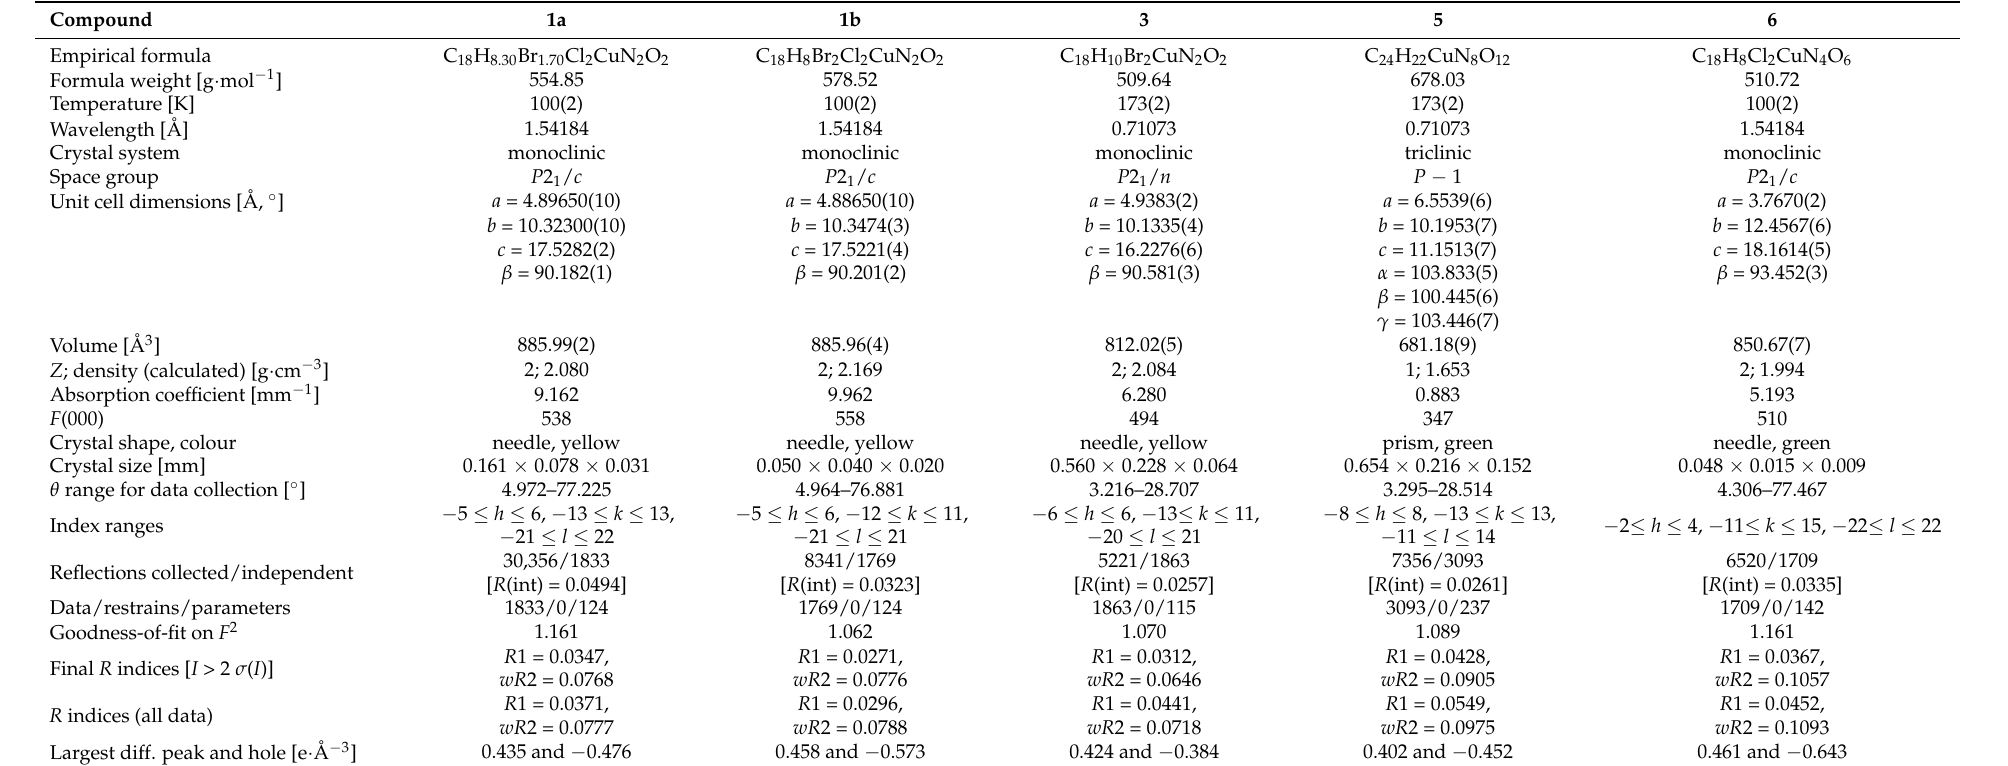
Table 7. Crystal data and structural refinement of 1a , 1b , 3 , 5 and 6